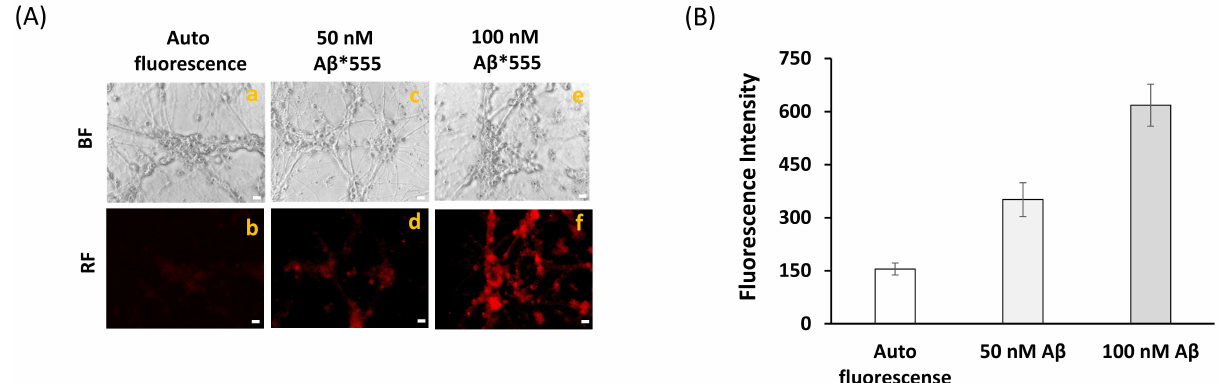
Figure 2. Fluorescence microscopy images of CGN stained with A β (1–42) HiLyte TM -Fluor 555. ( A ) Representative fluorescence microscopy images of mature CGN without staining-autofluorescence (b) and CGN stained with 50 nM (d) or 100 nM (f) of A β (1–42) HiLyte TM -Fluor 555 incubated for 1 h at 37 ◦ C and 5% CO 2 . Bright field (BF) and red fluorescence (RF) images are shown for representative selected fields. The exposure time for RF images was 0.4 s. Scale bar inserted in fluorescence microscopy images = 10 µ m. ( B ) Quantitative fluorimetric analysis of A β (1–42) HiLyte TM -Fluor 555 bound to CGN. The results yielded a 2.3-fold and 4-fold increase (mean of triplicate experiment ± s.e.) of the fluorescence of CGN stained with 50 nM and 100 nM A β (1–42) HiLyte TM - Fluor 555 with respect to the CGN autofluorescence,